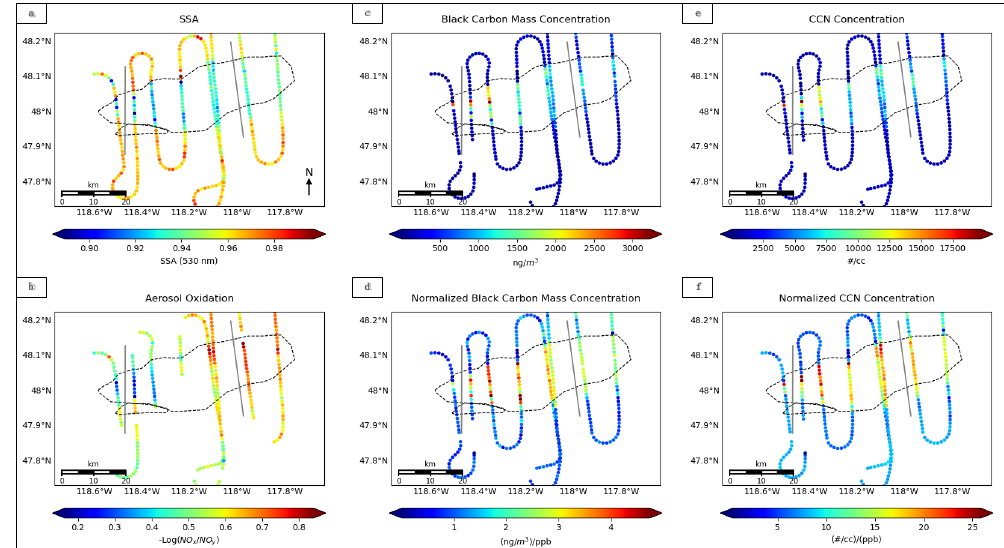
Figure 7. FIREX aircraft observations of the Williams Flats Fire on 06 August, 2019: ( a ) 530 nm SSA (PSAP / neph), ( b ) aerosol oxidation (derived from ozone-induced chemiluminescence), ( c ) Mass concentration of rBC (SP2), ( d ) rBC concentration normalized by CO (SP2, DACOM), ( e ) concentration of particles that can act as CCN at 0.34% supersaturation (CCN-100), and ( f ) CCN concentration normalized by CO (CCN-100, DACOM). The grey lines represent the boundaries between regions defined in Figure 1.